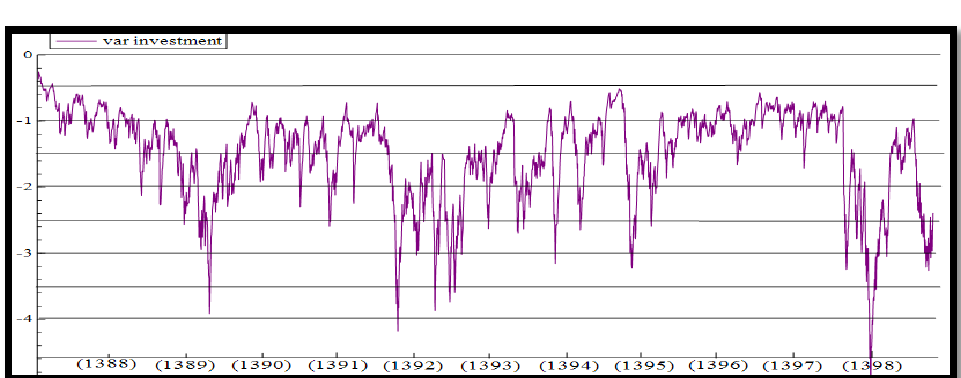
Figure 2. VaR of the investment industry